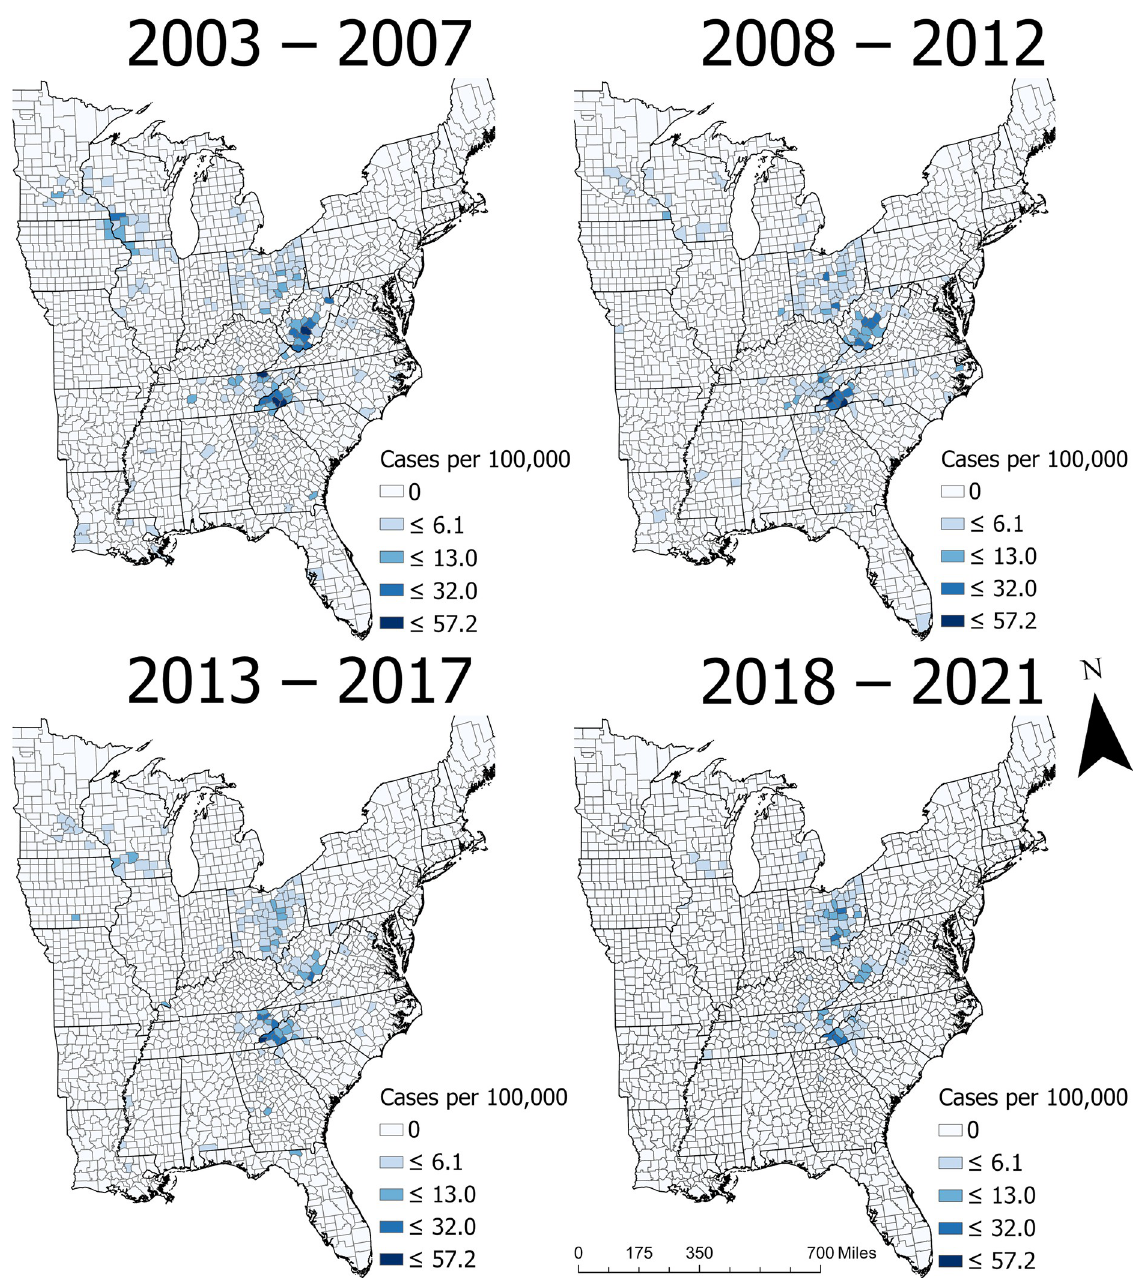
Fig 2. Crude county-level cumulative incidence of La Crosse virus neuroinvasive disease in the eastern United States from 2003–2021 (data obtained from ArboNET).